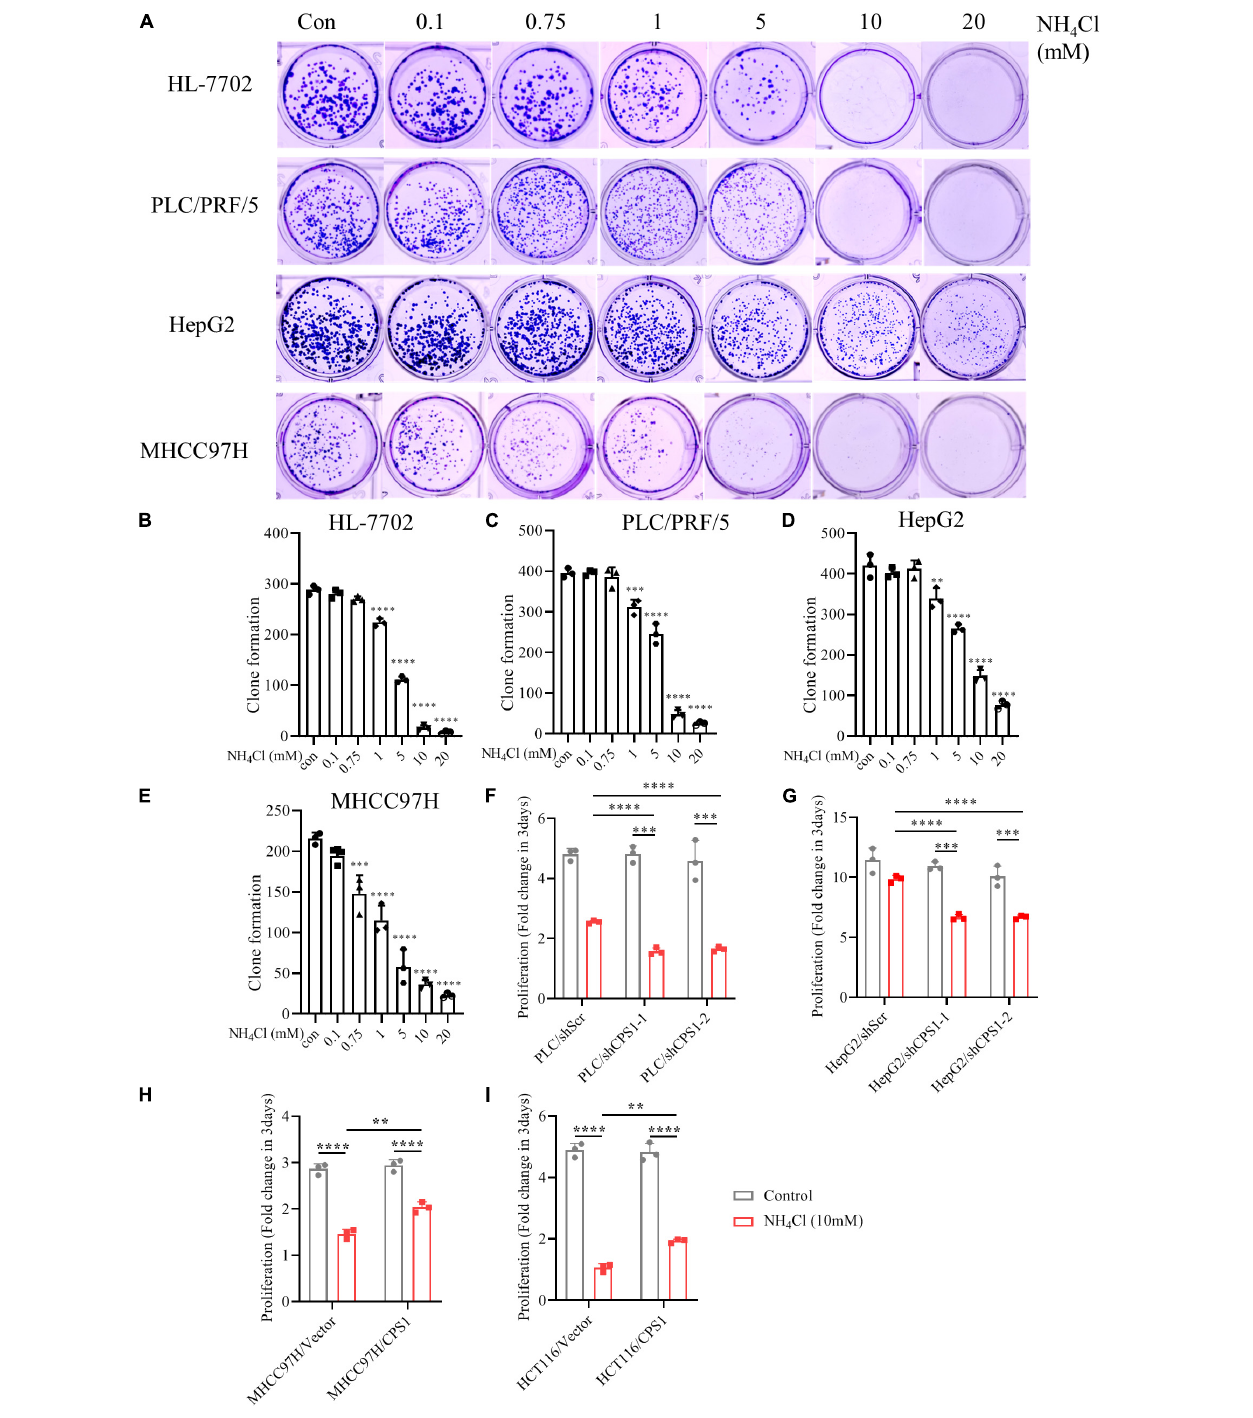
FIGURE 7 | Urea cycle protects cancer cells from high concentrations of ammonia. (A) Colony formation ability of HL-7702, PLC/PRF/5, HepG2 and MHCC97H under different concentrations of NH 4 Cl. The culture time was 2 weeks. (B–E) Colony number quantification of HL-7702, PLC/PRF/5, HepG2 and MHCC97H under different concentrations of NH 4 Cl by Image J. (F) Proliferation of PLC/PRF/5/shScr and PLC/PRF/5/shCPS1 cells cultured under control or 10 mM NH 4 Cl for 3 days. (G) Proliferation of HepG2/shScr and HepG2/shCPS1 cells cultured under control or 10 mM NH 4 Cl for 3 days. (H) Proliferation of MHCC97H/Vector, MHCC97H/CPS1 cells cultured under control or 10 mM NH 4 Cl for 3 days. (I) Proliferation of HCT116/Vector, HCT116/CPS1 cells cultured under control or 10 mM NH 4 Cl for 3 days. Values are the means ± SD of three independent experiments. ∗ p < 0.05; ∗∗ p < 0.01, ∗∗∗ p < 0.001, ∗∗∗∗ p < 0.0001.